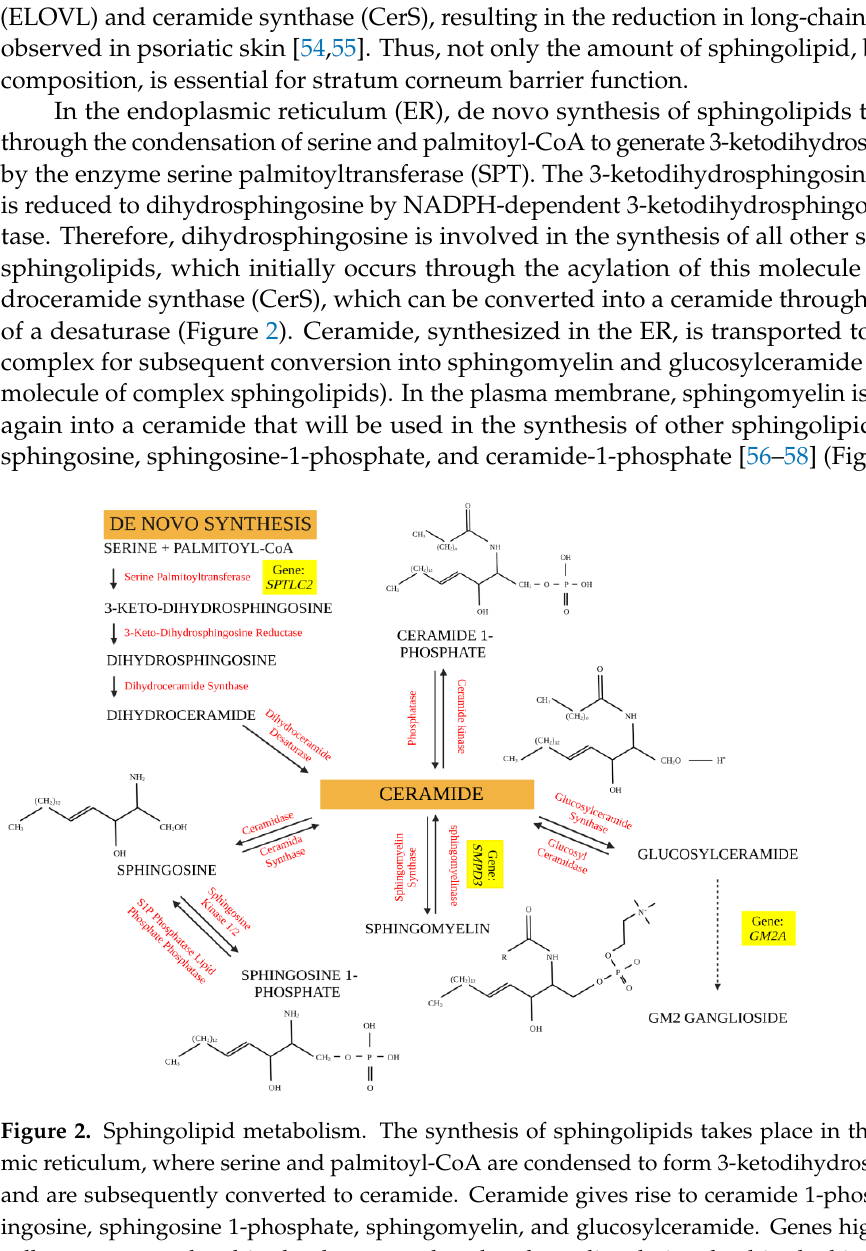
act in several cell signaling pathways or can be used as a substrate by sphingomyelinase for conversion into ceramide. The composition of fatty acid chains present in the structure of sphingolipids may impact the cellular pathways and processes involved in the pathogenesis of diseases dif- ferently. Short-chain ceramides are freely transported by cytosol and positively regulate membrane permeability, while long-chain ceramides functionally contribute to the epi- dermal barrier, preventing water loss and the entry of xenobiotics [54,57]. The saturation of the head group or acyl chain and the chain length of these molecules influence interac- tions between proteins and lipids that are crucial for cell signaling and metabolism [53,57]. In addition to their epidermal barrier function, sphingolipids act in the signaling of cellular events that compromise the immune functions of the skin and, mainly, the prolif- eration, differentiation, and apoptosis of keratinocytes [45]. The interaction between keratinocytes, lipids, and sphingolipids guarantees the in- tegrity of the epidermis and prevents excessive permeability to toxic molecules. Over the years, numerous studies have shown an association betwe en the skin’s lipid composition and skin diseases, including psoriasis and atopic dermatitis. Nomoto et al. (2018) identified that SMS2 deletion in a murine model resulted in a reduced glucosylceramide synthase activity, reduced sphingomyelin, CER[NS] and